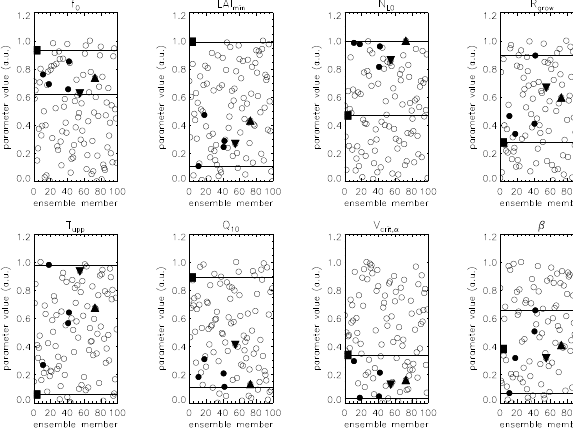
Fig. 5. The sensitivity of the 100 land surface ensemble members to individual parameters. The α 7 simulations are shown with filled symbols and the horizontal lines represent the minimum and maxi- mum values of each parameter covered by them. In decreasing or- der, the top three performing α 7 simulations (in terms of their frac- tional agreement with the observed dominant PFT in the Amazon region) are shown by upward-facing arrows, downward-facing ar- rows and squares